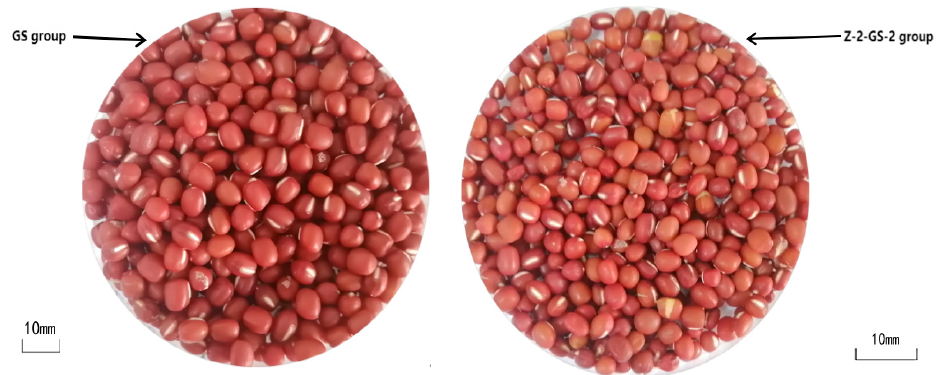
Figure 1. Vigna angularis sample diagram. Note: the GS group shows Vigna angularis without FSA spraying; the Z-2-GS-2 group shows Vigna angularis under FSA stress. spraying; the Z-2-GS-2 group shows Vigna angularis under FSA